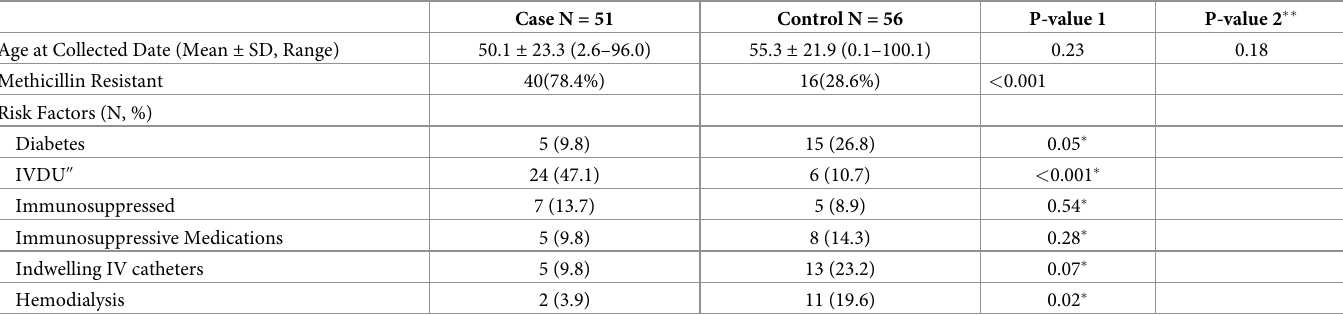
Table 1. Patient demographics by PVL 0 Case/Control status.